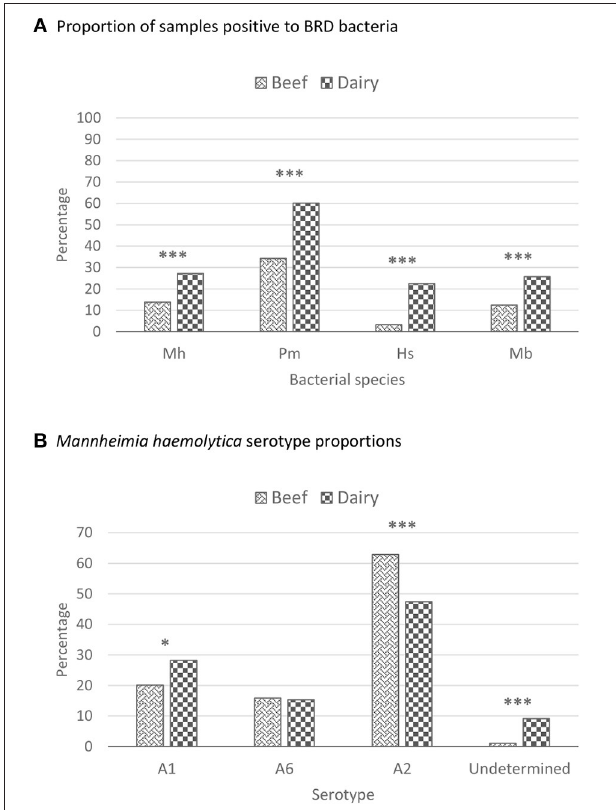
FIGURE 4 | Proportion of deep nasopharyngeal swabs that were positive for BRD-related bacteria and Mannheimia haemolytica serotype proportions recovered from beef and dairy-type cattle upon feedlot arrival. These percentages represent unadjusted proportions. The asterisks represent the statistical test significance levels as follows: “*” 0.05, “***” 0.001. BRD, bovine respiratory disease; Hs, Histophilus somni ; Mb, Mycoplasma bovis ;